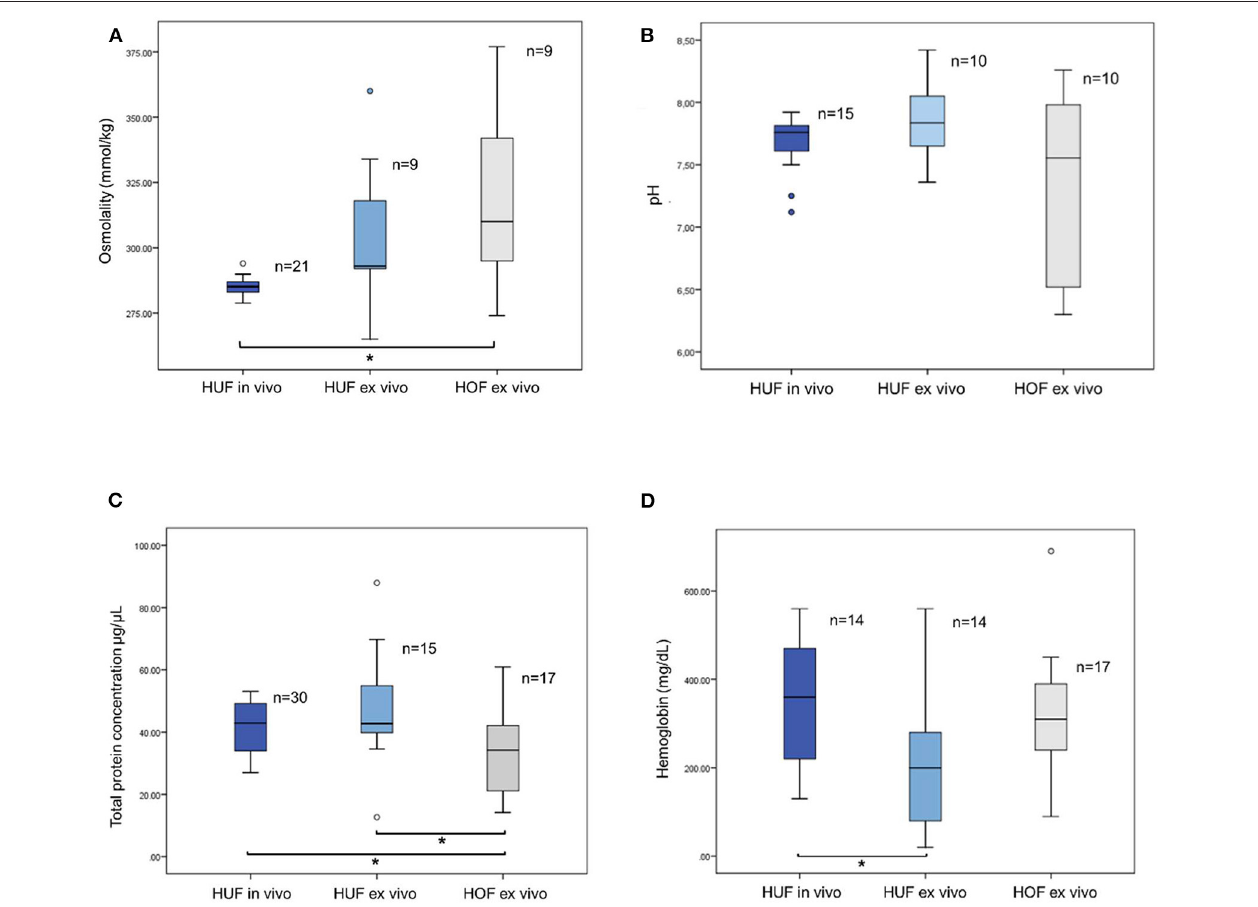
FIGURE 1 | (A) Osmolality values for human uterine fluids (HUFs) and human oviductal fluids (HOFs). The uterine fluids were collected either from oocyte donors (HUFs in vivo ) or from women undergoing hysterectomy (HUF ex vivo ). Oviductal fluids were collected from women undergoing salpingectomy (HOF ex vivo ). * Indicates significant differences ( p < 0.05). (B) pH values for human uterine fluids collected in vivo (HUF in vivo ), or ex vivo (HUF ex vivo ), and human oviductal fluids collected ex vivo (HOF ex vivo ). The two blue dots below the HUF in vivo bar correspond to the values of the outliers. No significant differences ( p < 0.05) were found among the three groups. (C) Total protein concentration for human uterine fluid collected ex vivo (HUF ex vivo ) and for human oviductal fluids collected ex vivo (HOF ex vivo ). * Indicates significant differences ( p < 0.05). (D) Hemoglobin concentration for human uterine fluids collected ex vivo (HUF ex vivo ) and for human oviductal fluids collected ex vivo (HOF ex vivo ). * Indicates significant differences ( p <